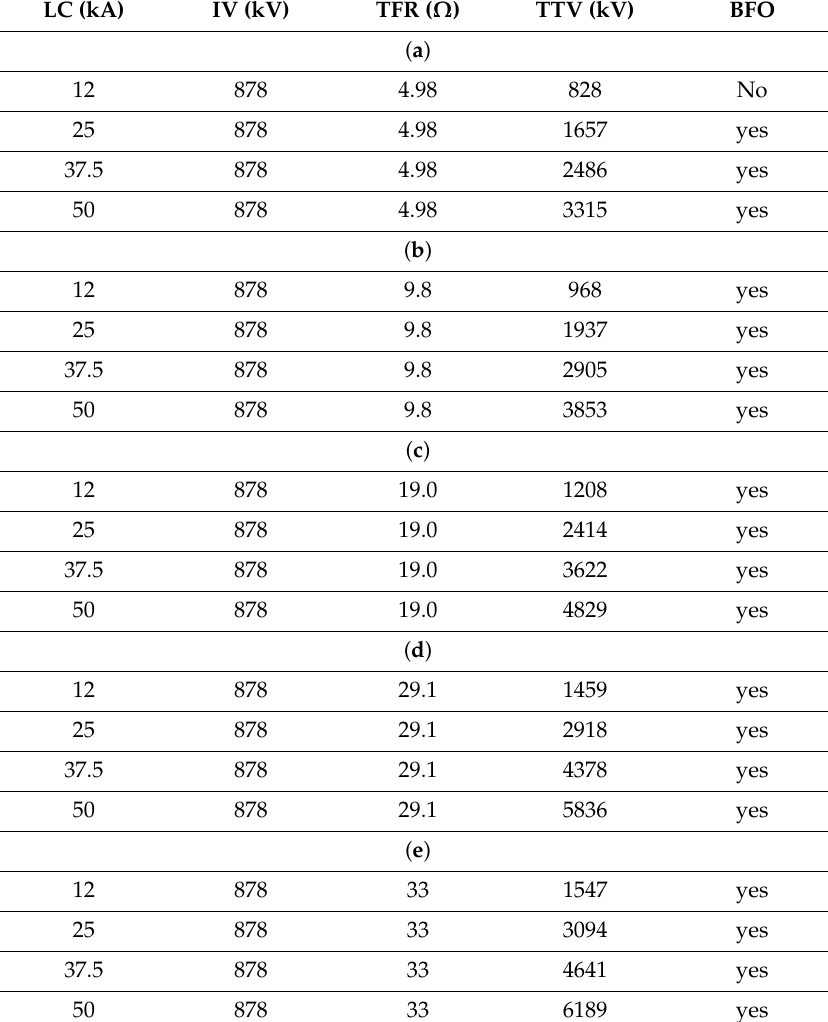
Table 4. ( a ): Resistance at the tower footing (earthing profile) of 4.98 Ω and various strokes of lightning. ( b ): Resistance at the tower footing (earthing profile) of 9.8 Ω and various strokes of lightning. ( c ): Resistance at the tower footing (earthing profile) of 18.7 Ω and various strokes of lightning. ( d ): Resistance at the tower footing (earthing profile) of 29.1 Ω and various strokes of lightning. ( e ): Resistance at the tower footing (earthing profile) of 34 Ω and various strokes of lightning. LC–Lightning current; IV–Insulating Voltage; TFR–Tower footing resistance; TTV–Tower top voltage; BFO–Back flash over. LC